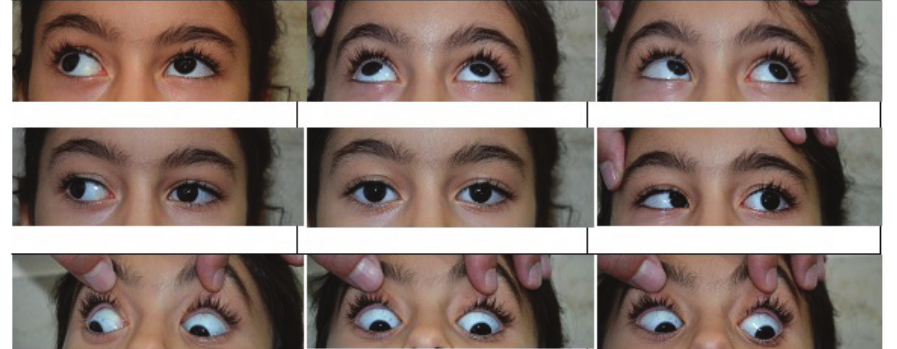
Figure 1. Exotropic Duane retraction syndrome, left eye. Top row, upshoot upon adduction in the left eye. Middle row, exotropia in primary position, limitation of abduction and adduction with retraction of the globe on adduction, all in the left eye. Bottom row, downshoots upon attempted adduction in the left